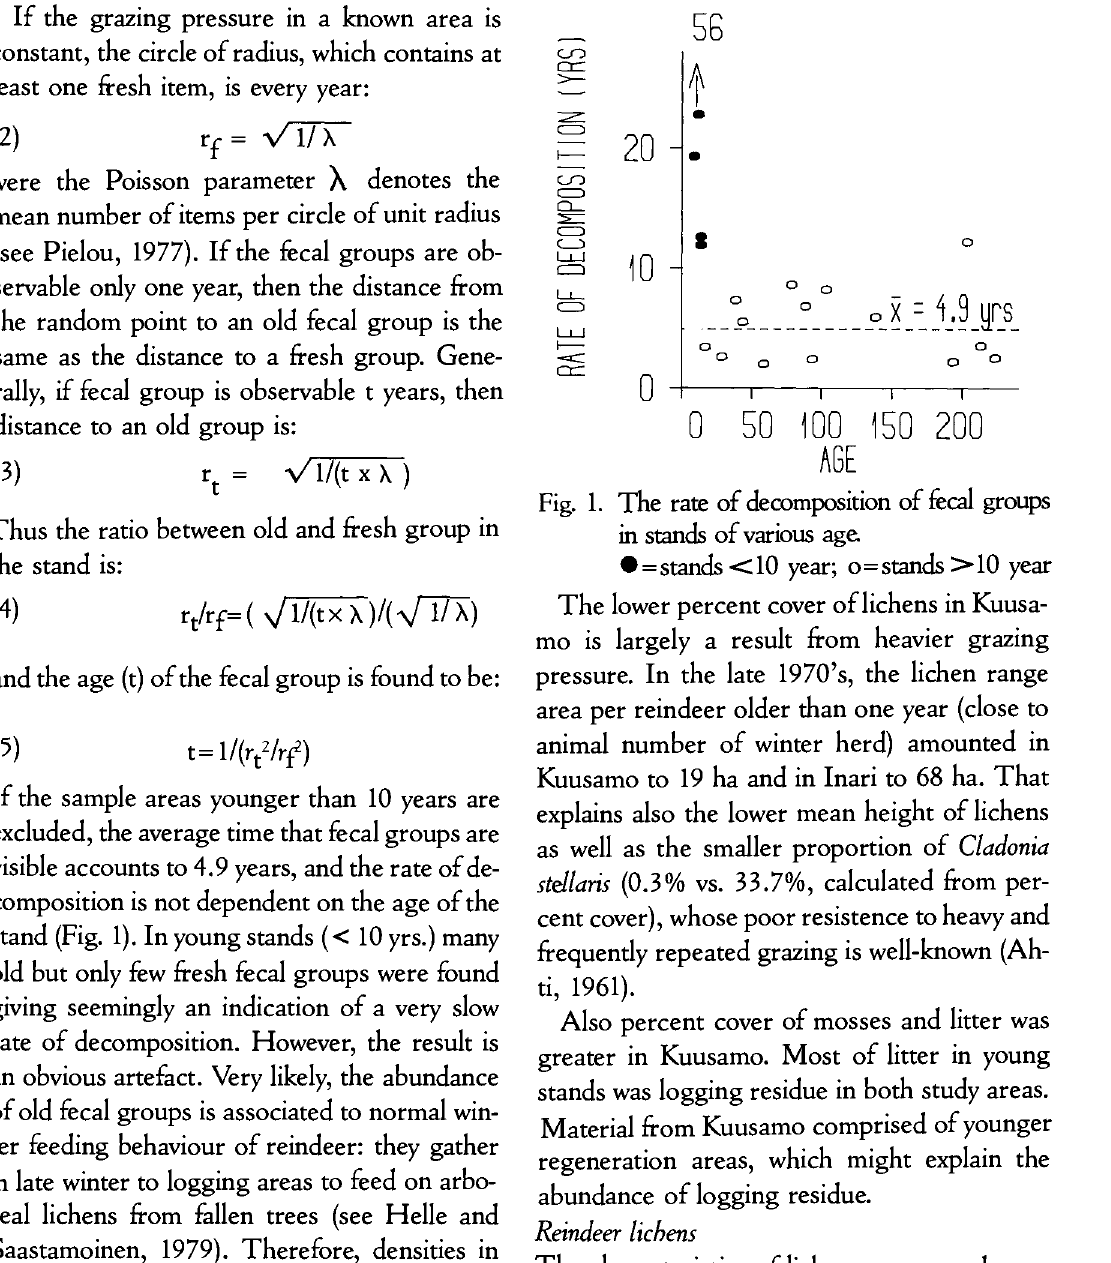
Fig. 1. The rate of decomposition of fecal groups in stands of various